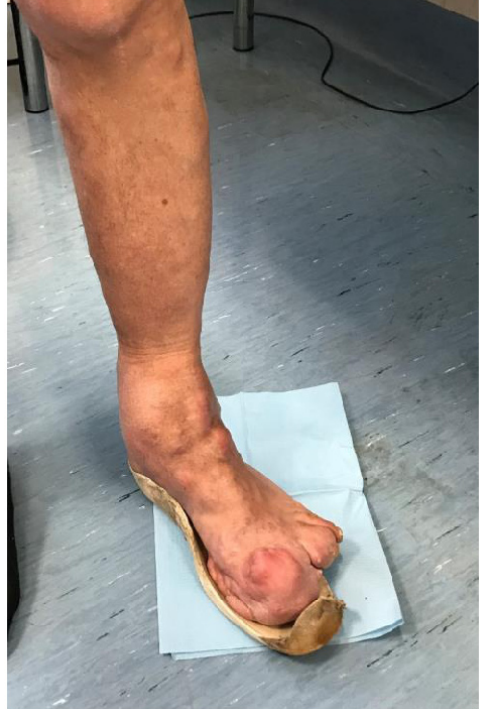
Figure 1. At the level of the medial tibial segment, bone exostosis can be observed on the deep planars, ~4 cm of diameter.